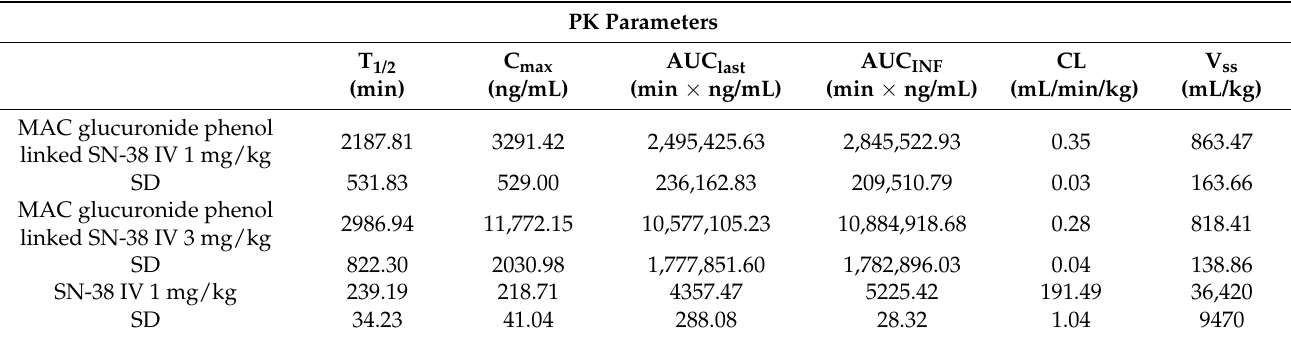
Table 3. Pharmacokinetic parameters of SN-38 at 1 mg/kg and albumin conjugated SN-38 at 1 mg/kg and 3 mg/kg of MAC glucuronide phenol linked SN-38 (as an equivalent dose of SN-38, 0.36 and 1.08 mg/kg respectively) after intravenous administration.